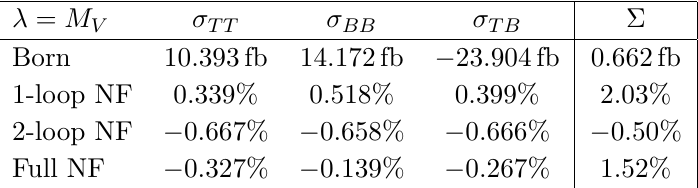
proVBFHH v1.1.0